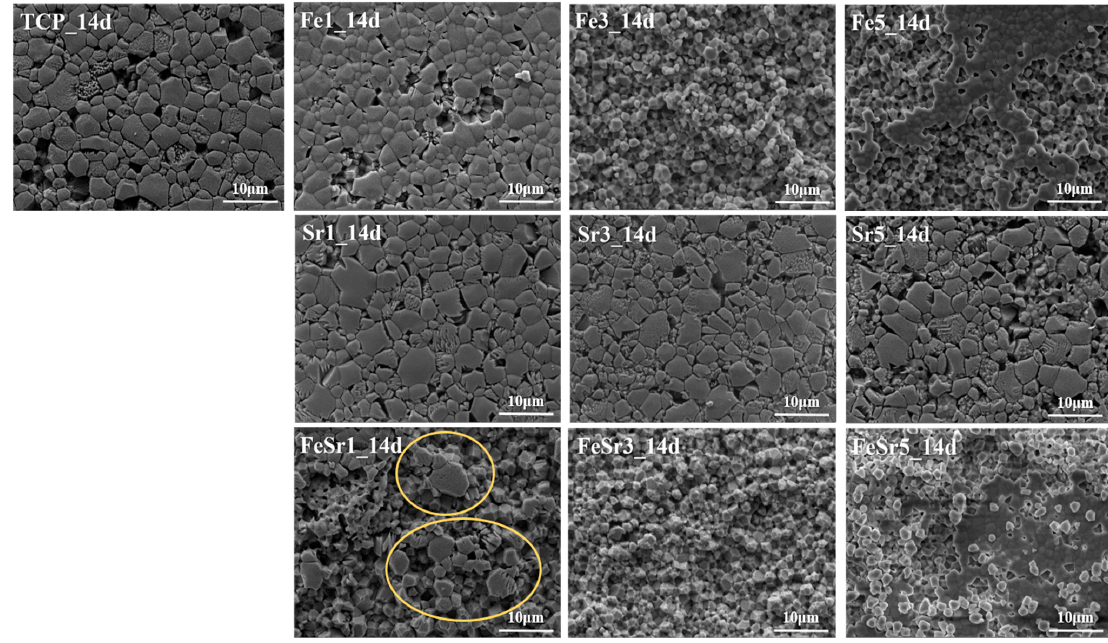
Figure 12. SEM image of disc surface after immersed in TRIS–HCl solution for 14 days.